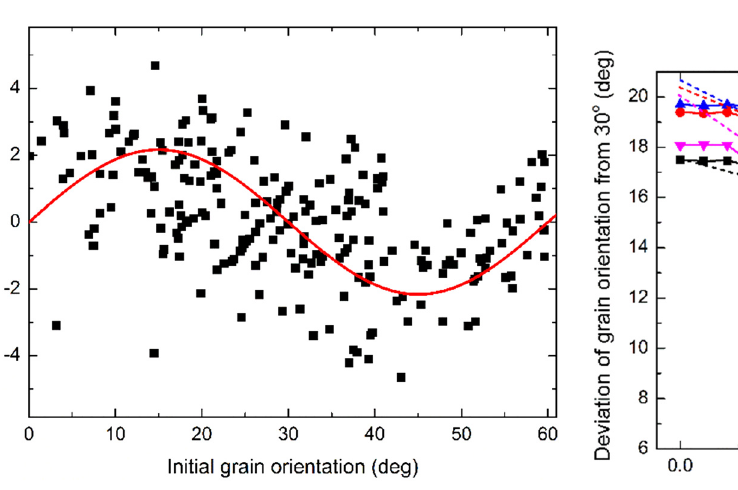
Figure 8: Dependence of grain rotation on the initial grain orienta - tion, with the dots for the rotation results of each grain, and the curve for the data fi tting.